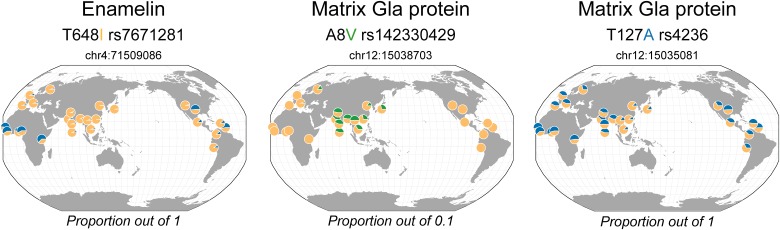
Geographical distribution of the dental protein variants common to archaic hominins in living people.The colored amino acid corresponds to the archaic variant. Yellow corresponds to the major allele; blue and green correspond to minor alleles with a proportion out of 1 and 0.1, respectively. The maps were generated in the Geography of Genetic Variants Browser (http://popgen.uchicago.edu/ggv/) [50].